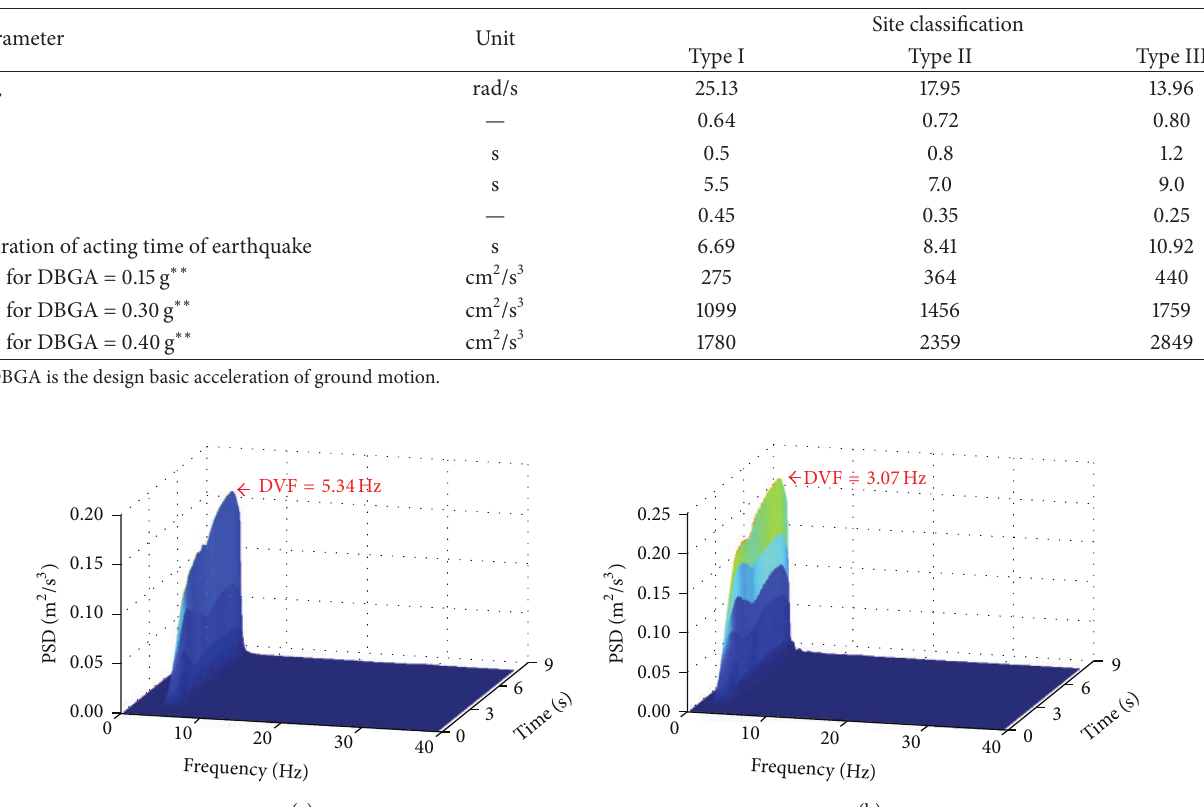
Table 2: Parameters of earthquake for different site conditions.